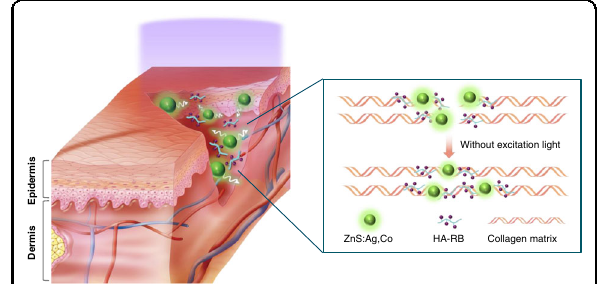
Fig. 1 Schematic illustration. The photochemical tissue bonding of incised collagen matrix by HA-RB/ZnS:Ag,Co mixtures under or after UV light